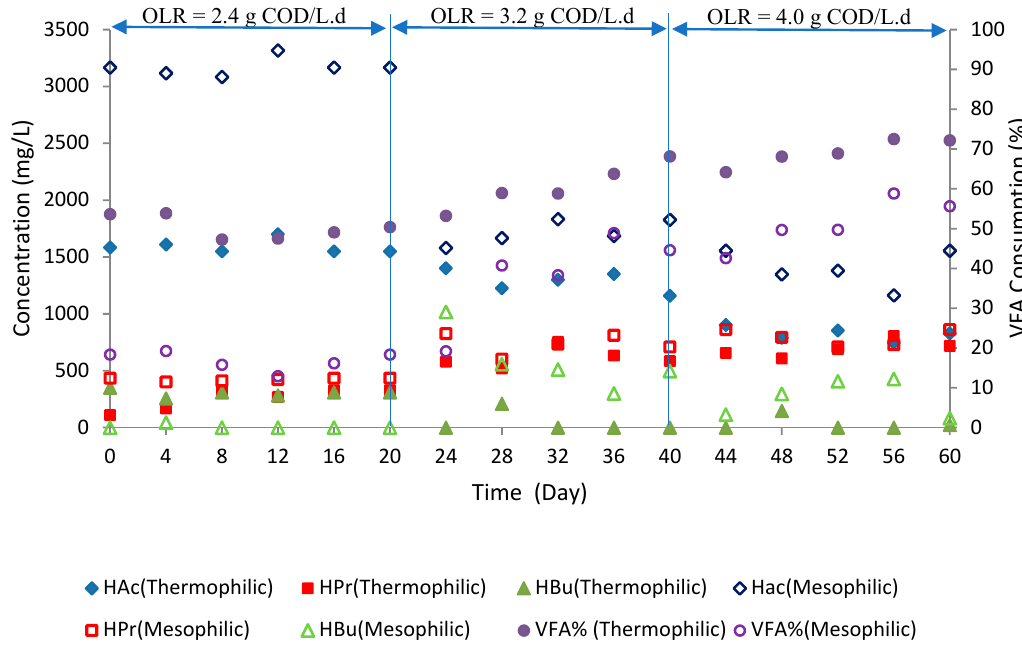
Figure 4. The pH and total alkalinity at various loading rates. Notes: Error bars show standard deviation of means ( n = 3).